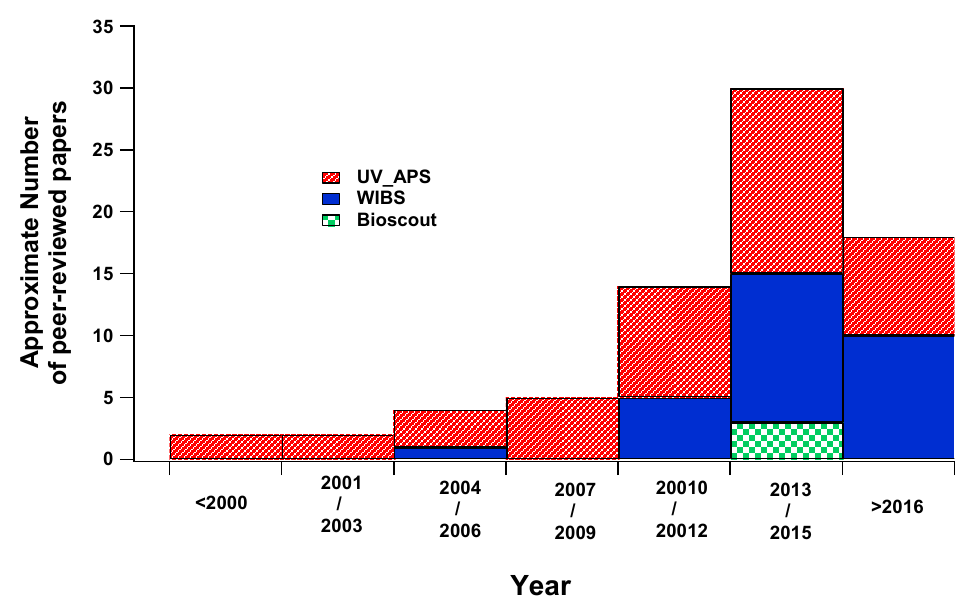
Figure 1. Indicates the increase in the number of peer reviewed manuscripts published over the last 20 years that have employed real-time fluorescent particle instrumentation for detection.